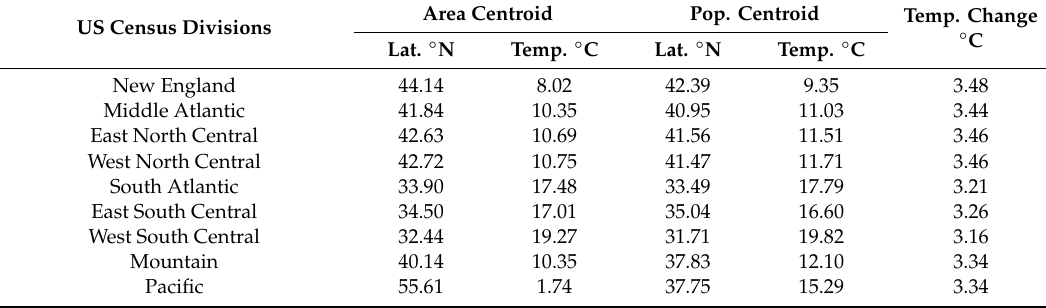
Table A4. Latitude and 2012 temperature at the area and population centroids, and temperature change at the population centroids at 3 ◦ C GMST increase, by census